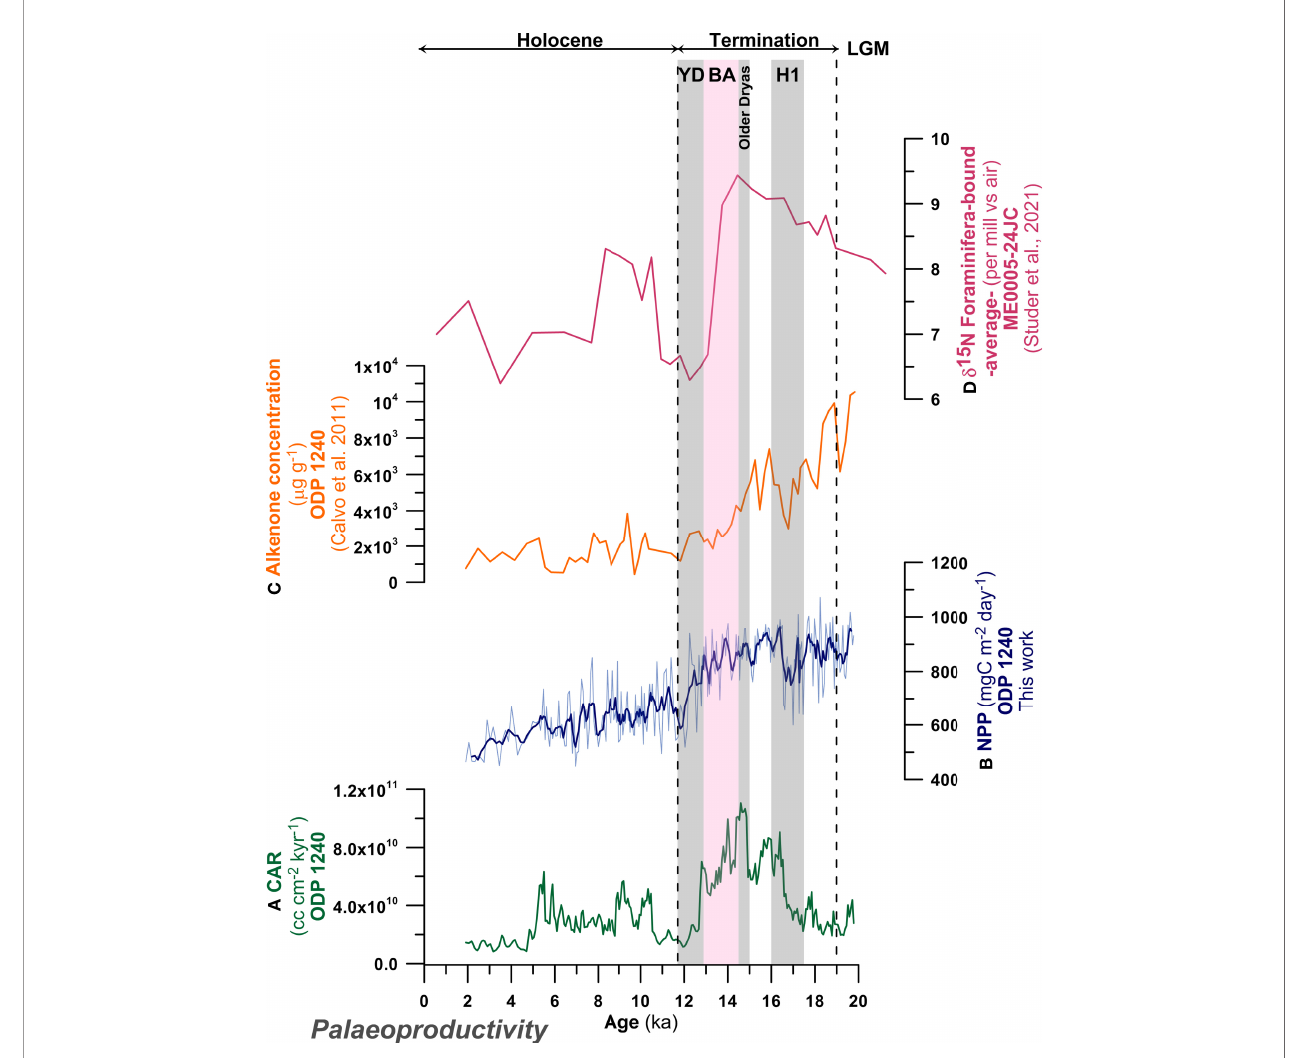
FIGURE 10 | Palaeoproductivity records for the last 20 kyr in eastern equatorial Paci fi c Ocean. Left panel: (A) Coccolith accumulation rate (CAR, cc cm -2 kyr -1 ) at ODP Site 1240; (B) coccolith-derived Net Primary Productivity (NPP, mg C m -2 day -1 ) at ODP Site 1240 (this work) including error estimates and with a 5-point running average smoothing; (C) alkenone concentration (µg g -1 ) at ODP Site 1240 (Calvo et al., 2011); (D) Foraminifera-bound d 15 N ( ‰ vs air) (average of Neogloboquadrina dutertre i and N. incompta ) (Studer et al., 2021). Shaded areas indicate the Heinrich 1 (H1), Older Dryas, Bølling – Allerød (BA) and Younger Dryas